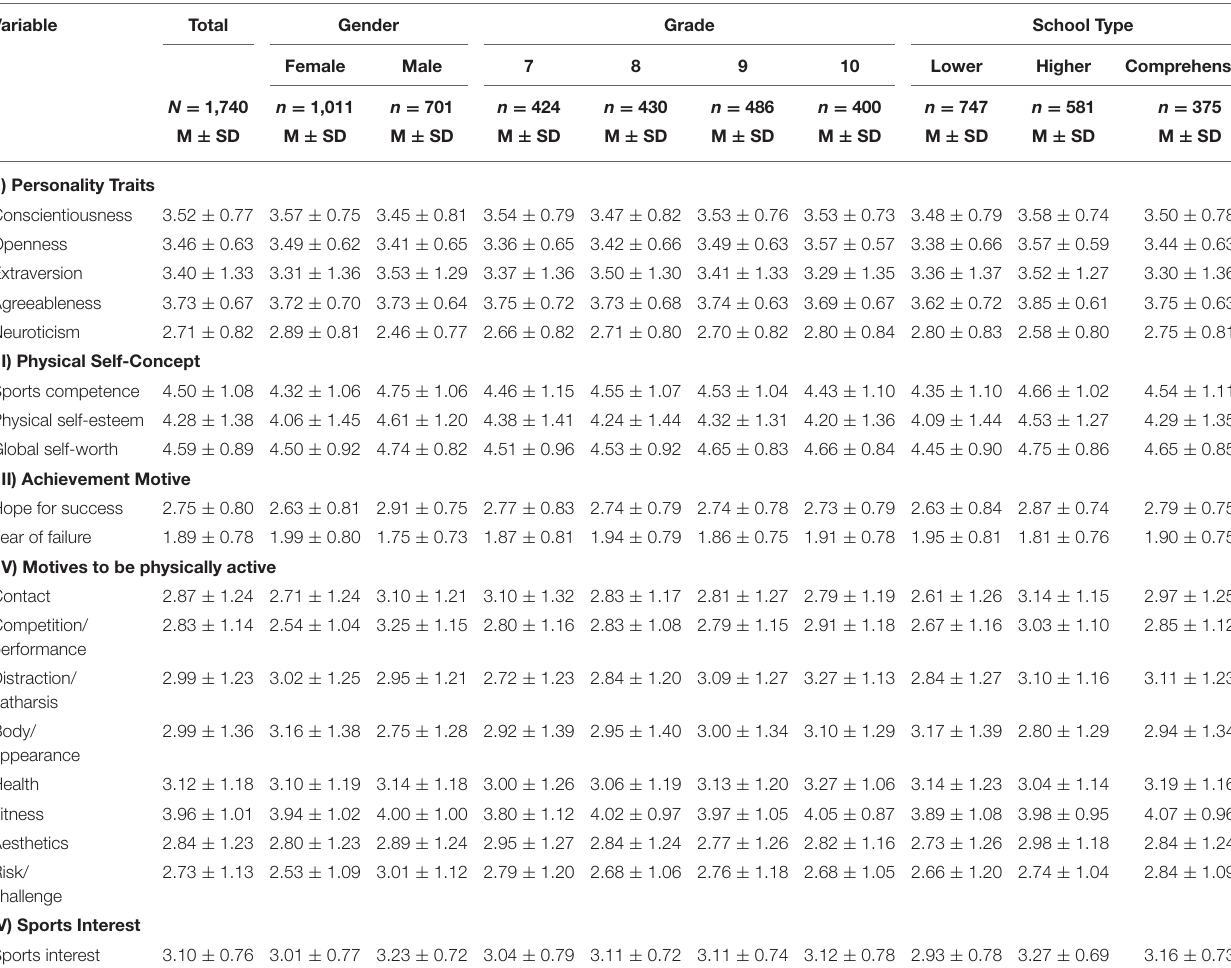
TABLE 2 | Overview of student characteristics—total, gender, grade, and school type.